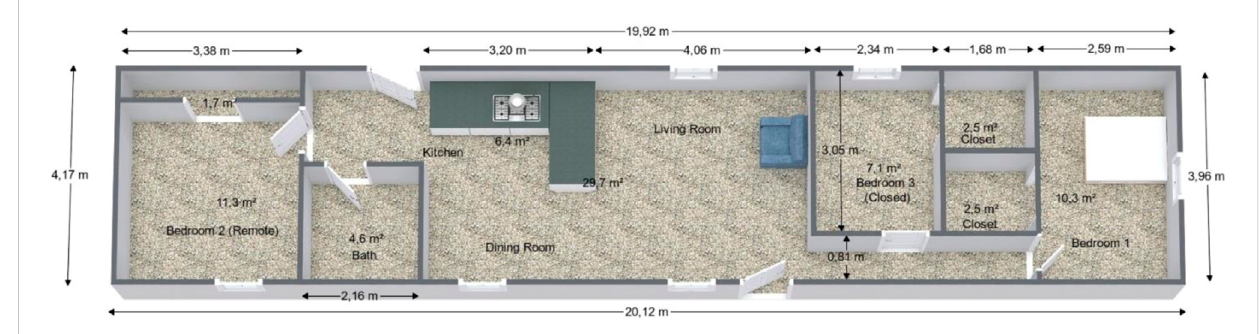
FIGURE 1 Geometry of the experimental facility (Bukowski, 2007).